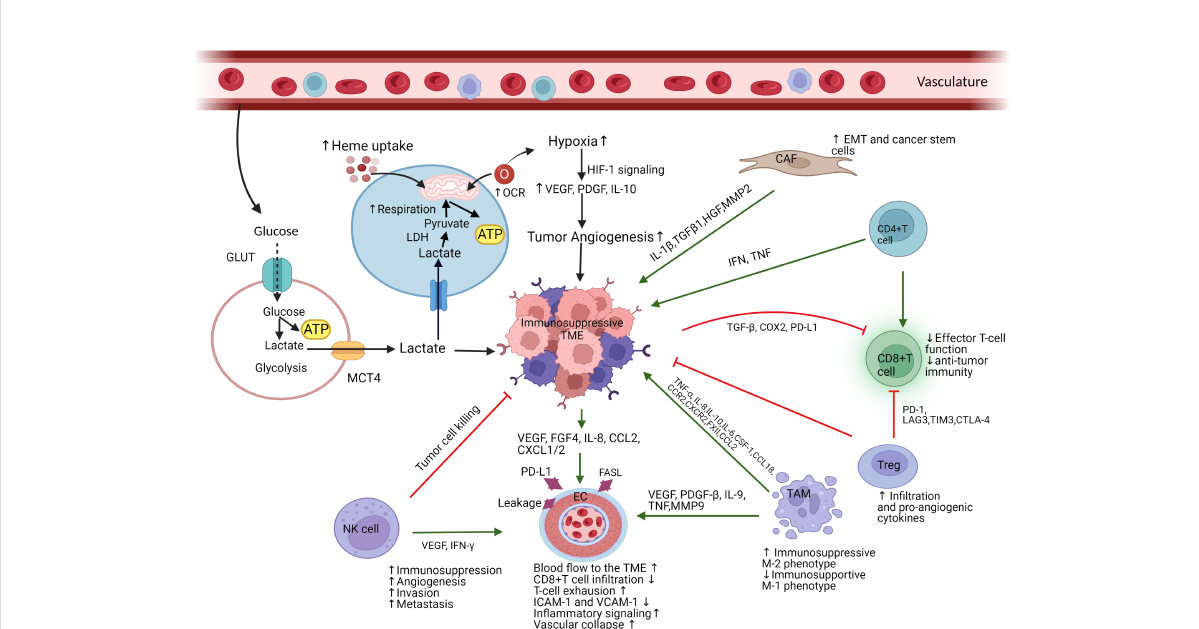
FIGURE 1 Schematic representation of immunosuppressive TME mainly mediated by tumor cells ’ high heme uptake and mitochondrial respiration. (Figure created with BioRender.com accessed on 19 November 2022). Immune suppressive cells and components in fi ltrate into the TME, interact with tumor cells, causes immune resistance (immunosuppressive), and promote tumorigenesis. Due to excessive consumption of nutrients, tumor cells release lactate which causes acidosis and recruits immunosuppressive cells into TME. Tumor cells ’ high heme uptake and mitochondrial respiration associated with an elevated consumption of oxygen promote hypoxia and angiogenesis, which drive an immunosuppressive TME. Hypoxia activates HIF-1 and VEGF signaling cascade which causes dysfunctional vascularization and generates tumor invasion and metastasis. TAMs enhance an immunosuppressive TME function via the polarization of immunosupportive M1-like phenotype to immunosuppressive M2- like phenotype. TAMs also promote tumor EC function via activating VEGF, PDGF- b , TNF, and IL-9. NK-cells stimulate EC function by targeting VEFG and IFN- g . Receiving signal from TAMs and NK-cells, tumor endothelial cell become immunosuppressive by increasing blood fl ow into TME and stimulating the expression of PD-L1 which ultimately increase T cells exhaustion and apoptosis. Immunosuppressive TME causes cytotoxic CD8+ T cells dysfunction and T cells exhaustion. CAFs are responsible for EMT and cancer stem cell generation by activating ECs and releasing cytokines and growth factors which promote tumor growth, angiogenesis, and tumor vasculature. GLUT, glucose transporter; ATP, adenosine triphosphate; MCT4, monocarboxylate transporter 4; LDH, lactate dehydrogenase; OCR, oxygen consumption rate; HIF, hypoxia- inducible factor; VEGF, vascular endothelial growth factor; CAF, cancer associated fi broblast; EMT, epithelial mesenchymal transition;